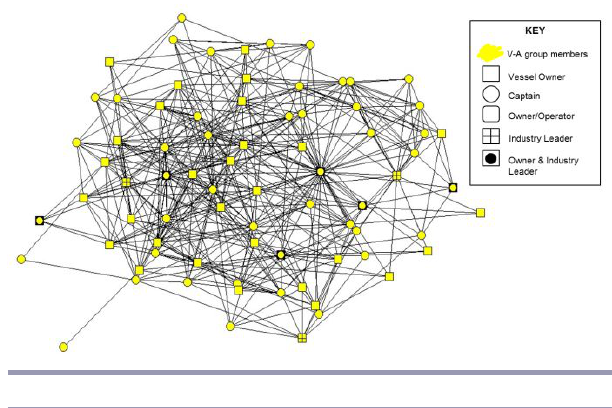
Fig. 7 . Normalized outdegree and indegree boxplots for each ethnic community of fishers. E-A = Euro-American, K-A = Korean-American, V-A =